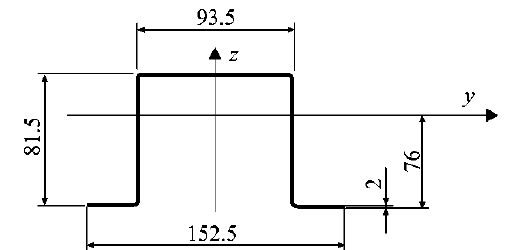
Fig. 9. Actual cross section of rib